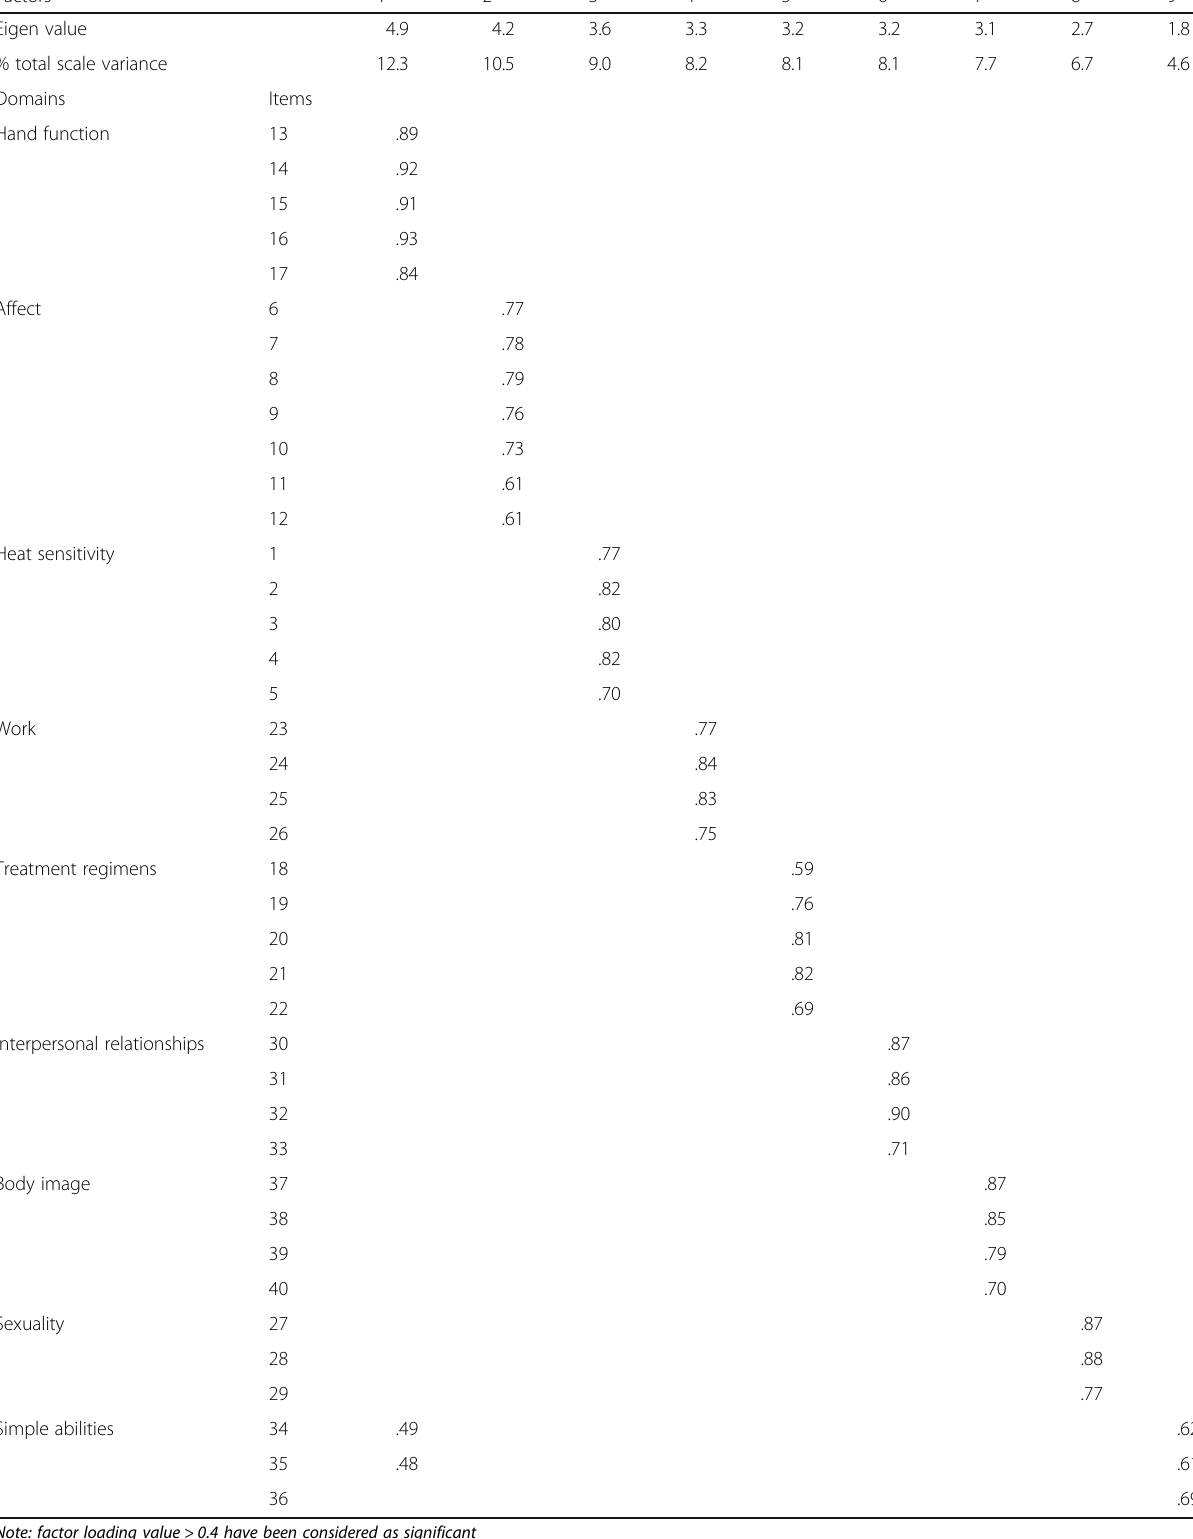
Table 4 Rotated component matrix resultant from the Principal component analysis after Varimax with Kaiser Normalization